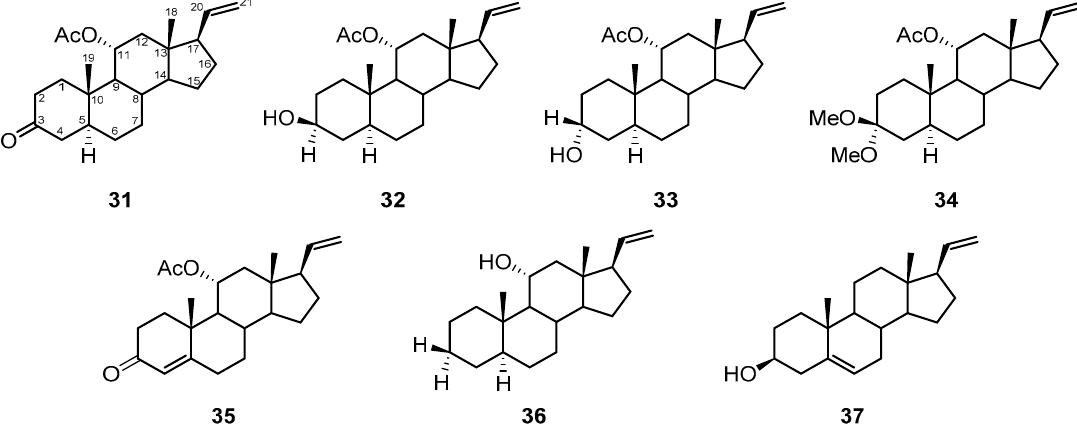
Figure 10. Structures of pregnanes ( 31 – 37 ).